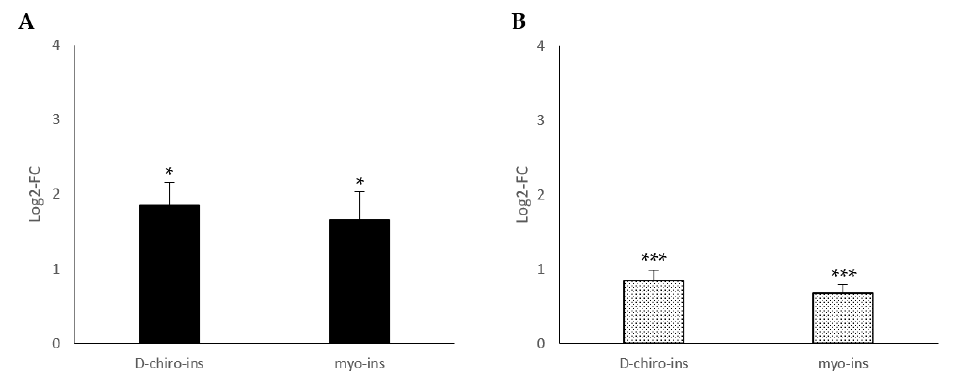
Figure 5. Modulation of the expression for the PPAR- γ variant 1 (PPAR- γ v1) messenger in ( A ) SGBS and ( B ) LiSa-2 adipocyte cells. D-chiro-Ins and myo-Ins concentrations used for the experiments were 60 µM. Results are reported as mean ± SD of data obtained from 3 independent experiments in technical triplicate. Bars show log 2-fold change (treated vs. control). Data were analyzed by one-way ANOVA with repeated measures followed Duncan–Waller post hoc test. p -values ≤ 0.05 were considered statistically signi fi cant. * p < 0.05 versus control; *** p < 0.001 versus control.